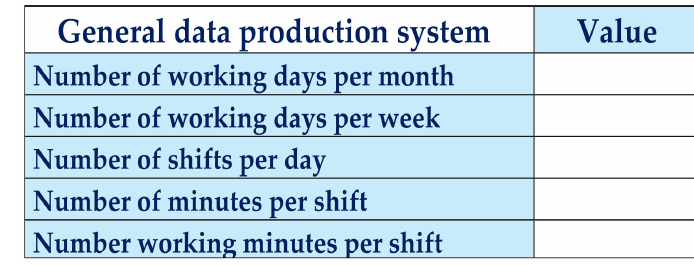
Figure 3. General data of the production system.